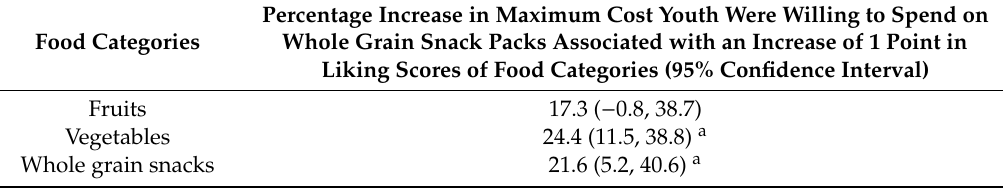
Table 4. Association between average liking scores of youth for fruits, vegetables, and whole grain snacks and the maximum cost they were willing to spend on whole grain snack packs (n =